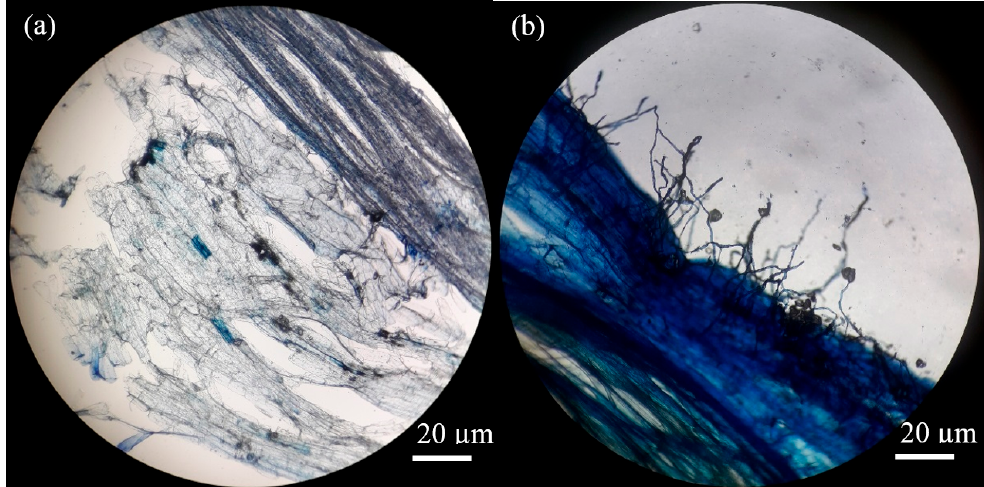
Figure 3. Winter wheat root sections (1 cm length) stained with Sheaffer ® blue, sampled from ( a ) zero tillage (ZT) and ( b ) conventional tillage (CT) soils in February. Imaged with a Samsung Galaxy ® (Seoul, South Korea) Android 3J camera smartphone at a magnification of ×40 of a Vickers ® (York, UK) compound microscope.